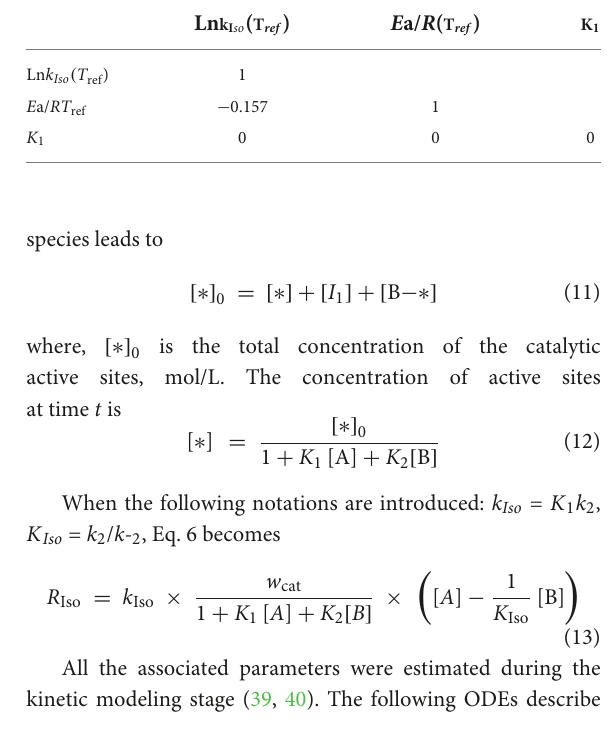
TABLE 4 Correlation matrix of kinetics